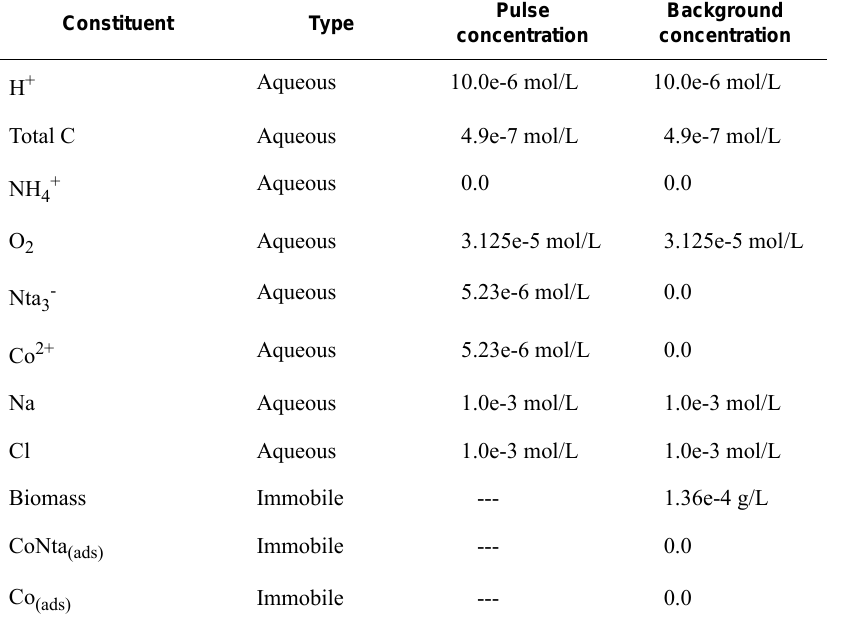
Table 40. Concentration data for example 15.